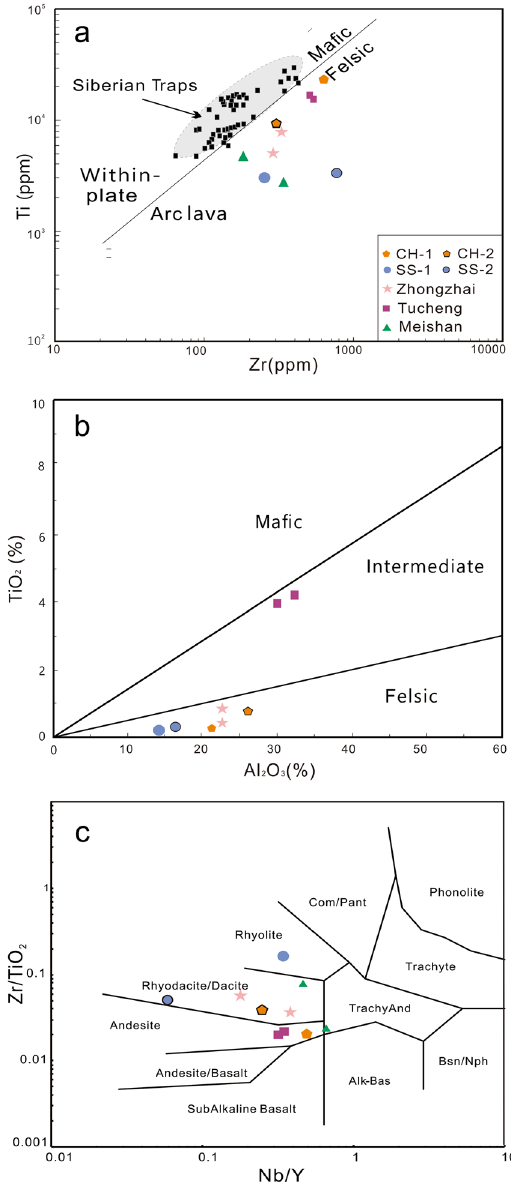
Figure 7. ( a ) Zr versus Ti diagram (after Pearce (1982)). ( b ) Plot of TiO 2 and Al 2 O 3 . (3) Zr/TiO 2 versus Nb/Y